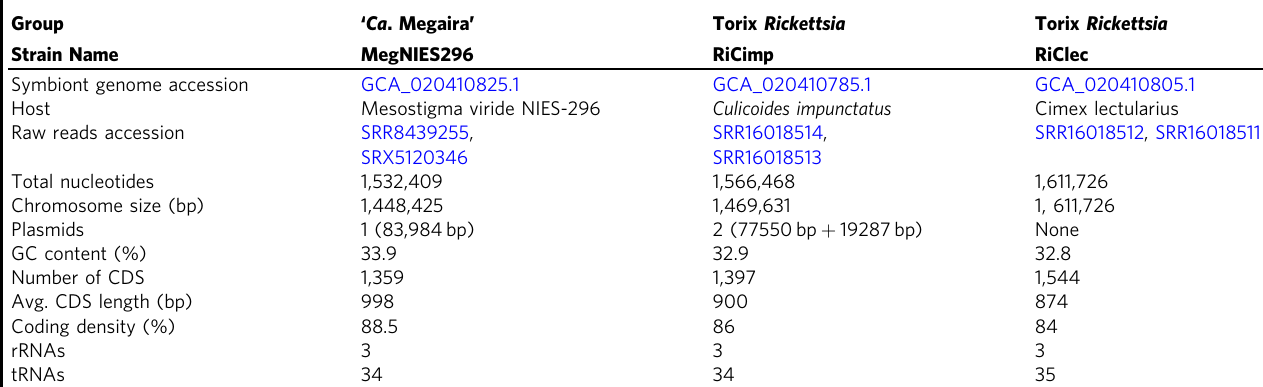
Table 1 Summary of the closed ‘ Ca . Megaira ’ and Torix Rickettsia genomes completed in this project.